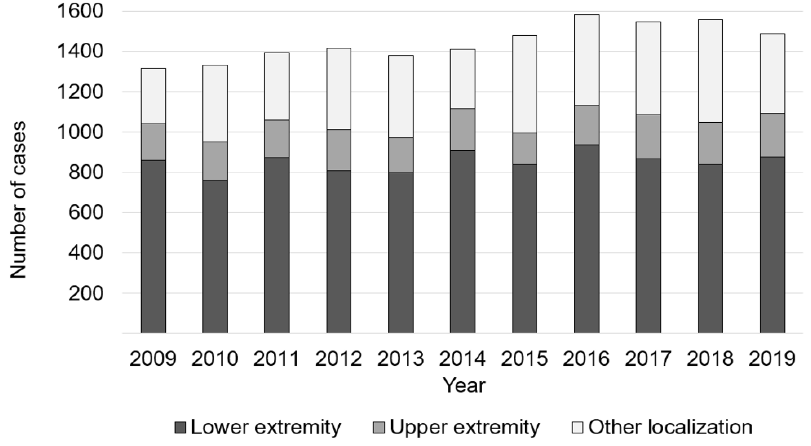
Figure 3. Anatomical region dependent changes osteomyelitis cases.